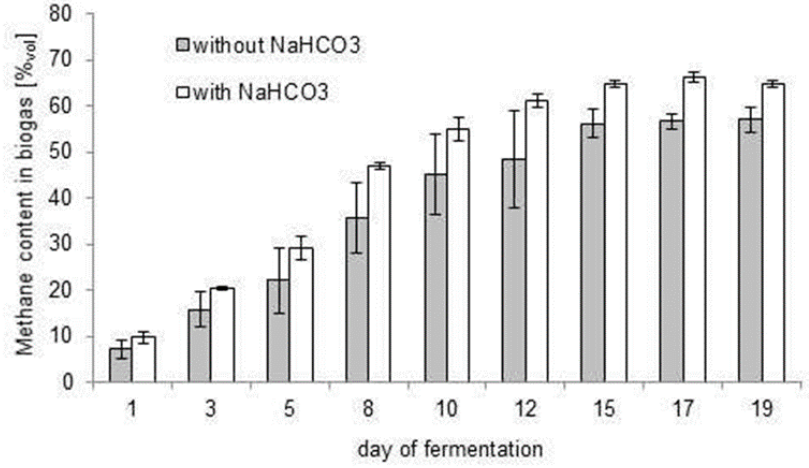
Figure 5. Methane content in the biogas on successive days of incubation in bottles with and without the addition of sodium bicarbonate (series 3).